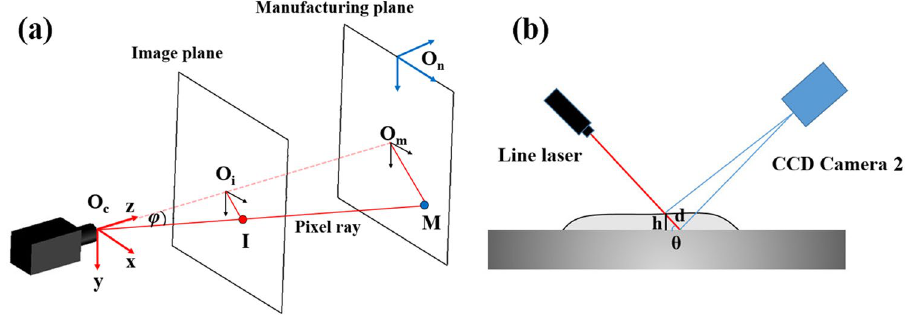
Figure 2. The measurement of melt pool height and solidified layer. ( a ) The relationship between pixels in the image plane and the coordinates in the real world, ( b ) Calculating the height through the line